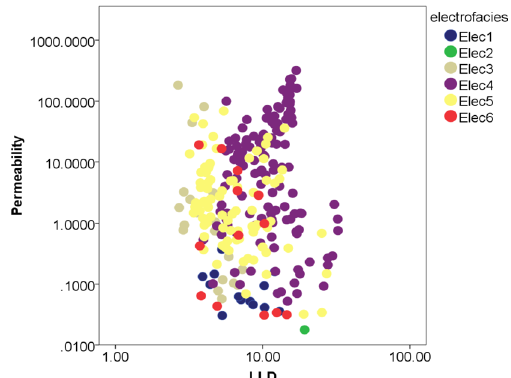
Fig. 17 DEN–K crossplot in